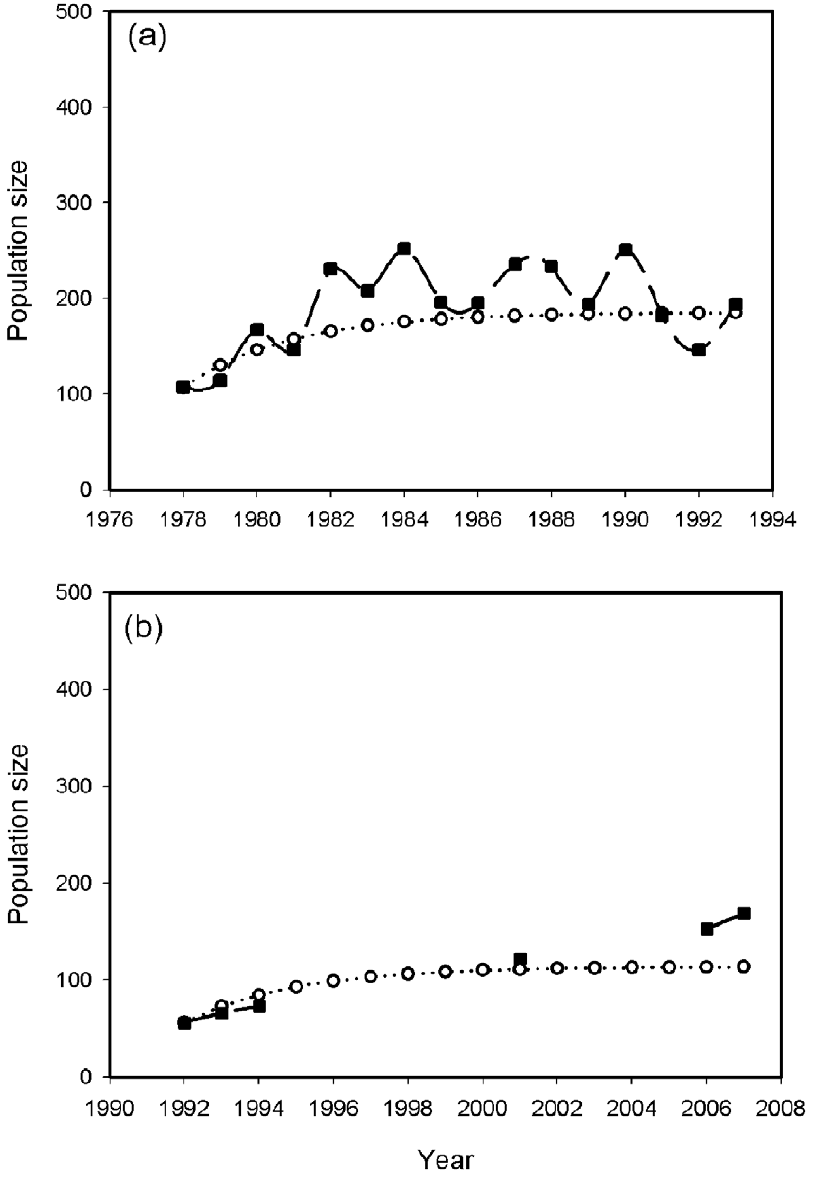
Figure 2. Comparisons between observed historical data (solid squares) and model projections (open circles) of the swan populations in (a) the River Wylye and (b) the River